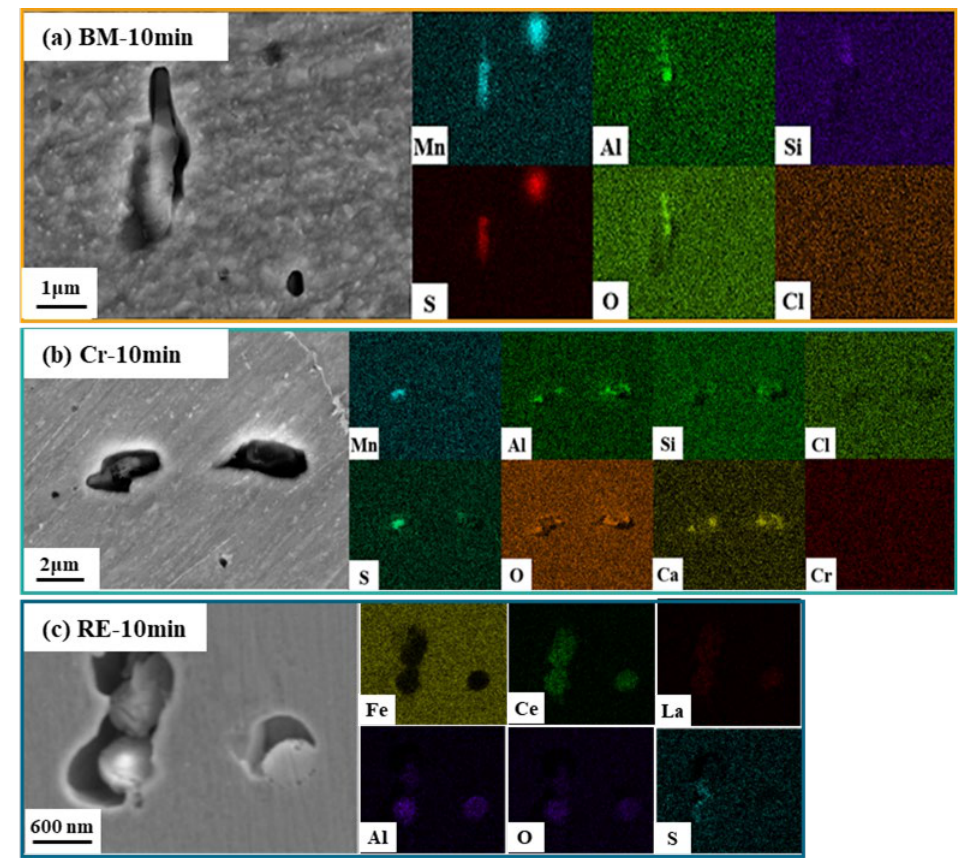
Figure 3. Immersion test results of ( a ) BM, ( b ) Cr, and ( c ) RE steel rebars after 10 min.